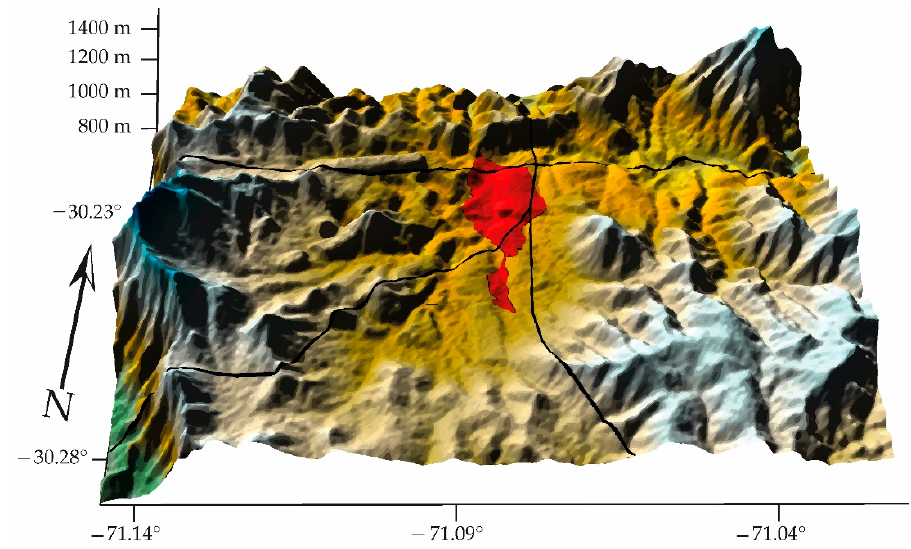
Figure 17. Geomorphology of Andacollo, C K, Andacollo = 4.46 (Pacheco et al., 2020) (GCS, WGS84). (k) The Concón station is located in the commune of the same name (Figure 18):